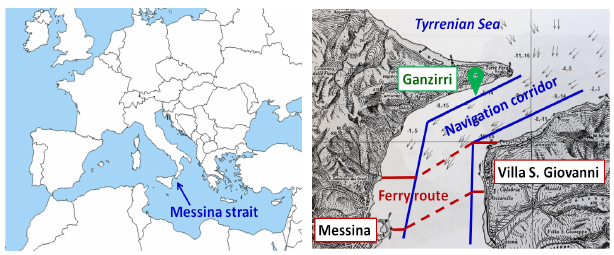
Fig. 21. Messina strait: non-exploitable areas reserved for navigation and Ganzirri site location shown by the green pin. IN the present analysis, the time series covering a two-month period are considered as approximately representative of the annual resource distribution. Top